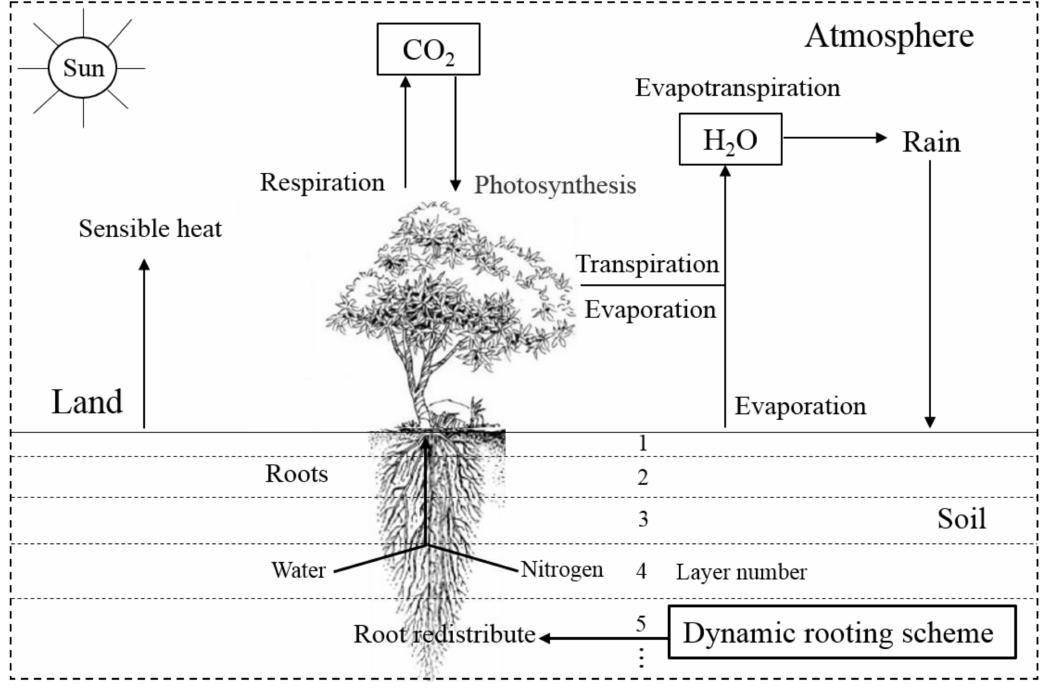
Figure 1. Schematic diagram of the impacts of the dynamic rooting scheme on land–atmosphere